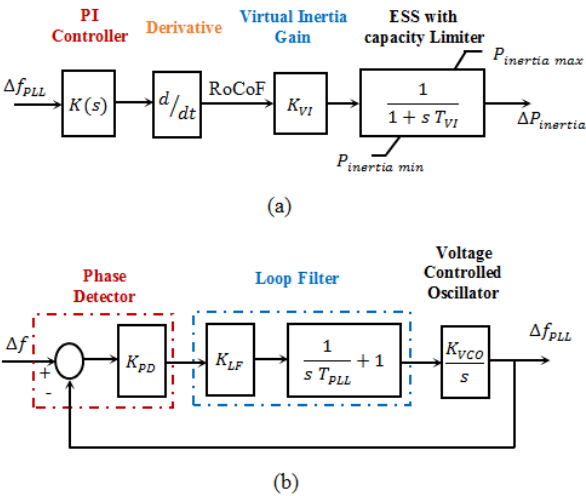
Figure 3. The dynamic structure of ( a ) virtual inertia control and ( b ) the PLL.